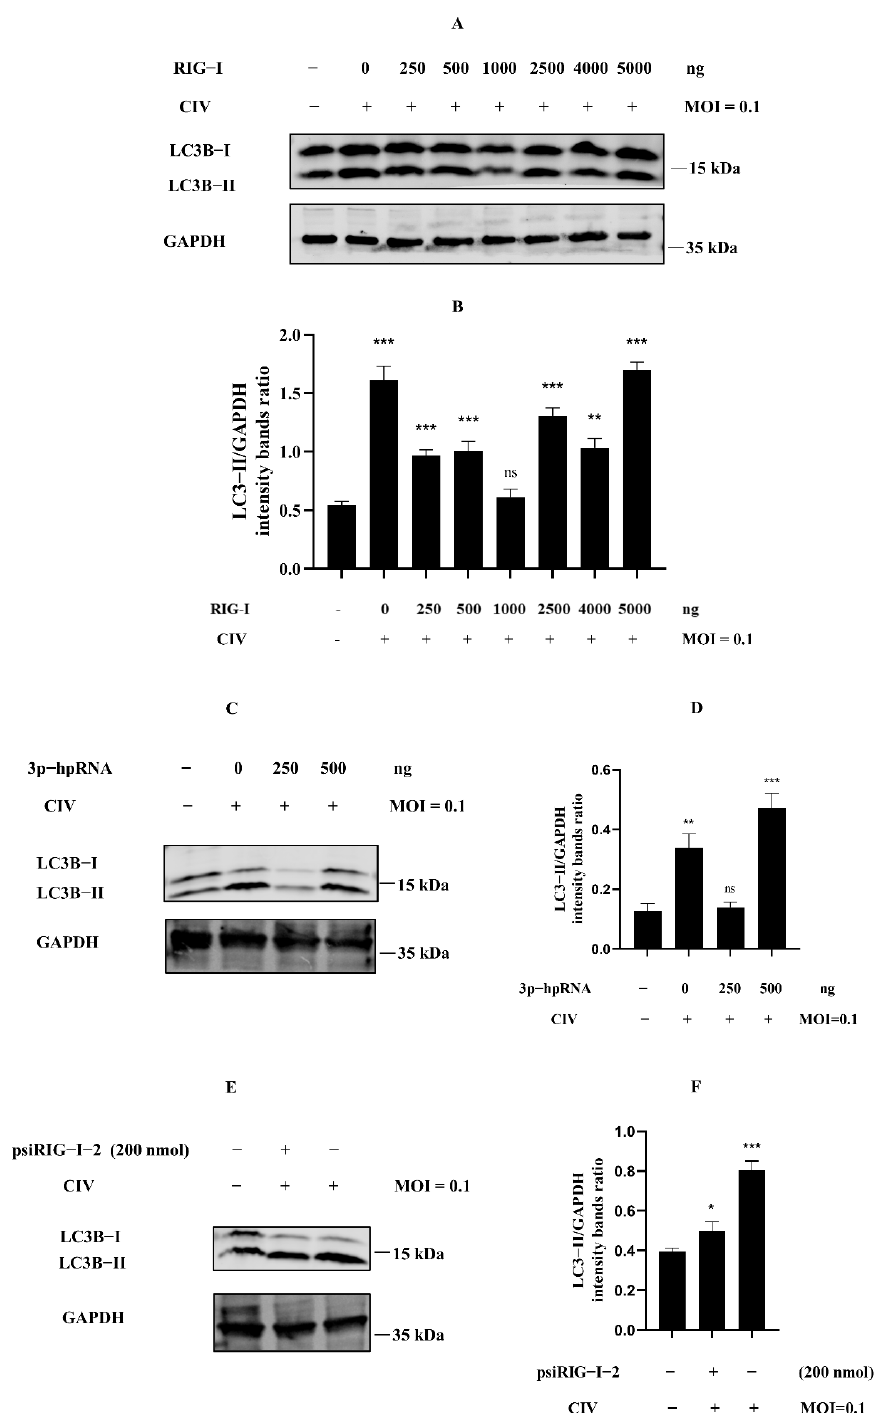
Figure 2. Excessive expression of RIG-I induced autophagy in CIV infection. ( A ) MDCK cells were transfected with indicated concentrations of Flag-RIG-I plasmid; after 24 h, cells were inoculated with H3N2 CIV at 0.1 multiplicity of infection (MOI), and the expression level of the endogenous LC3B was determined by Western blotting. ( C , E ) MDCK cells were transfected with indicated concentrations of RIG-I agonist ( C ) or psiRIG-I − 2 ( E ); after 24 h, cells were inoculated with H3N2 CIV at 0.1 MOI, and the expression level of the endogenous LC3B was determined by Western blotting. GAPDH served as a protein sample loading control. ( B , D , F ) Protein band intensity of LC3B-II and GAPDH were used for Western blotting quantification analysis. Samples were analyzed in three independent experiments (ns indicated no significance, * p < 0.05, ** p < 0.01, *** p <